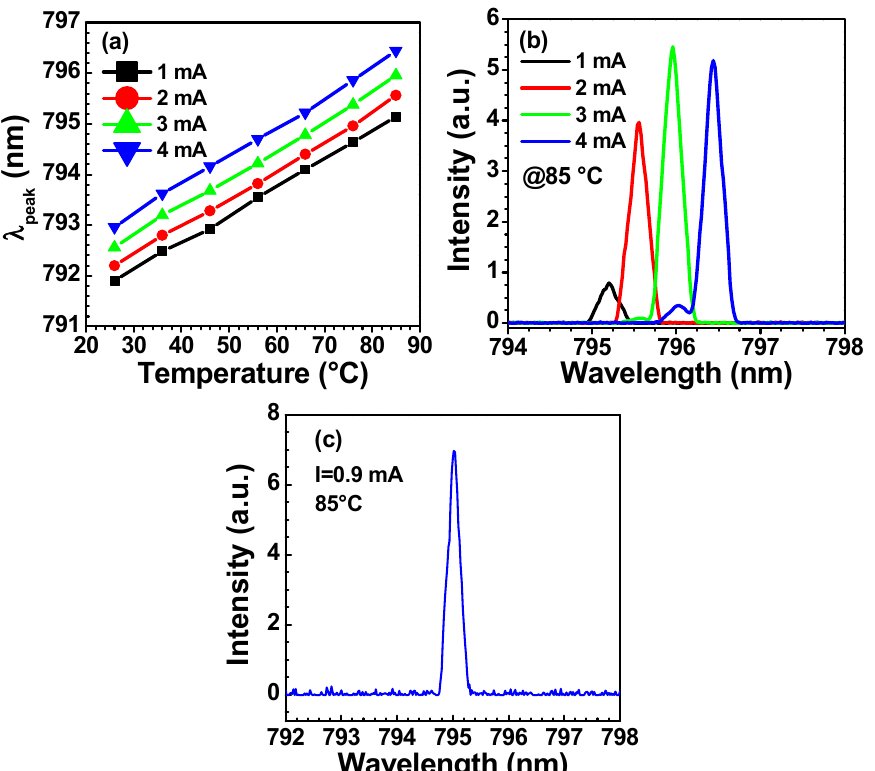
Figure 6. ( a ) Temperature dependence of the peak wavelength ( λ peak ) at different injection currents. ( b ) Emission spectrum of the VCSEL at 85 °C and different injection currents. ( c ) Emission spectrum of the VCSEL at 85 °C and an injection current of 0.9 mA. The device has a surface grating period of 500 nm, a depth of 150 nm, and a D g = 5 μ m.